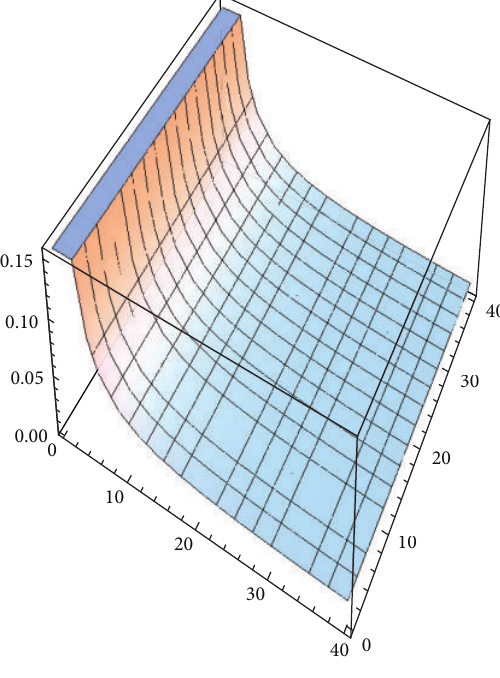
Figure 5: Solution of (48) (piezometric head).